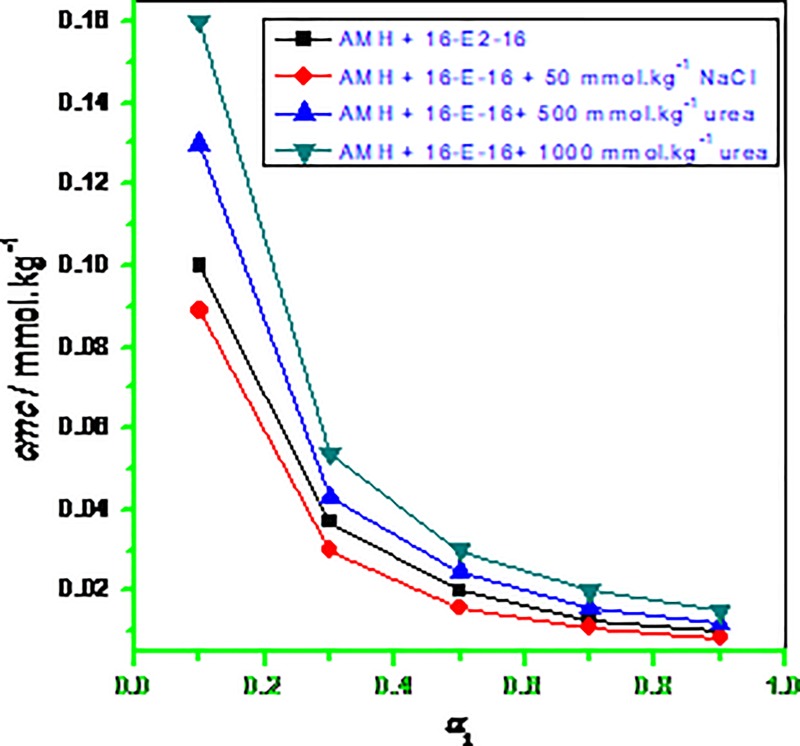
Variation of cmc/cmcid of AMH-16-E2-16 mixture versus mole fraction (α1) of 16-E2-16.